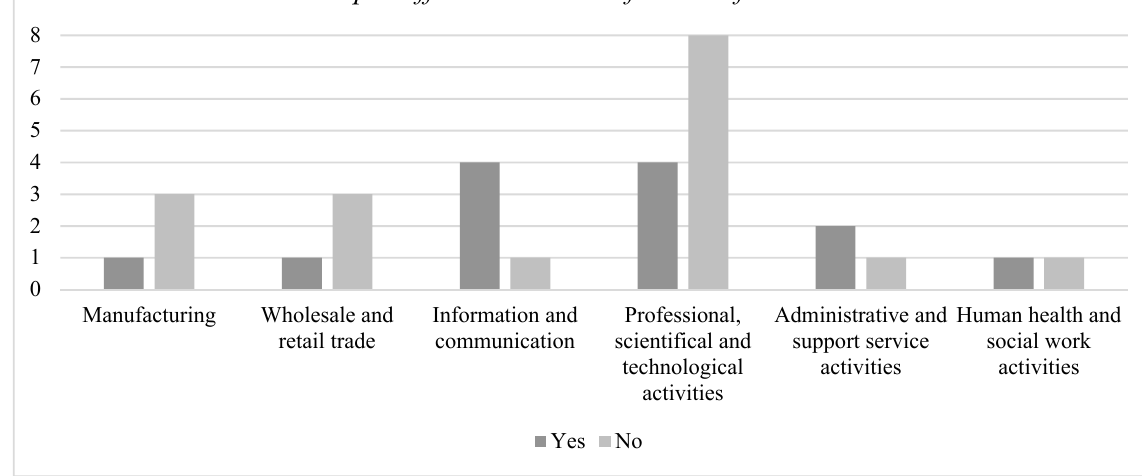
Figure 4. Chart showing whether the spin-off has its own definition about the term stakeholder per sector.